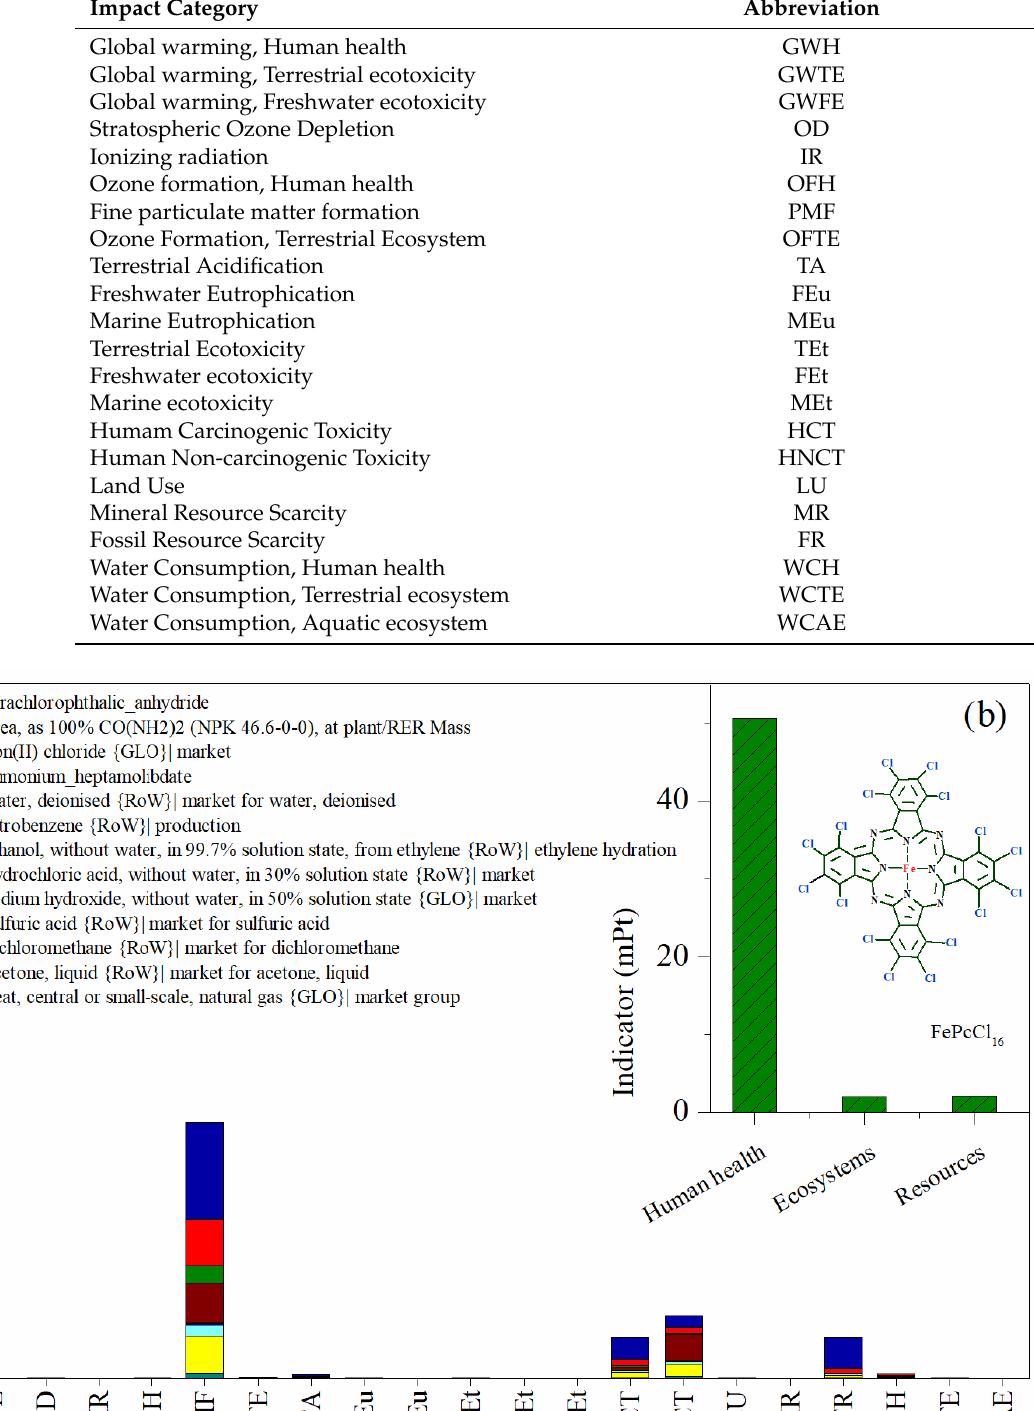
Table 2. Impact categories selected for the analysis.